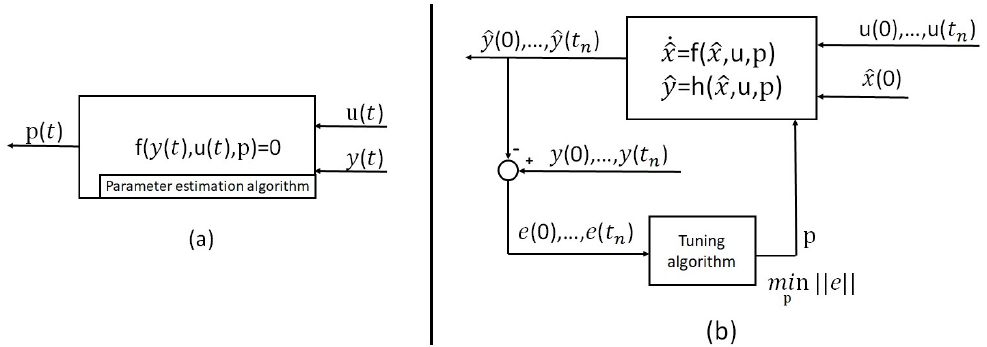
Figure 7. Parameter estimation schemes. ( a ) Online parameter estimation, ( b ) Offline parameter